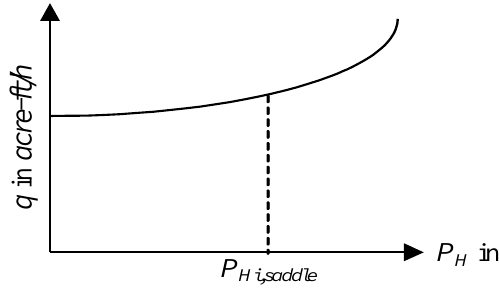
Figure 4. Hydroelectric unit power generation.